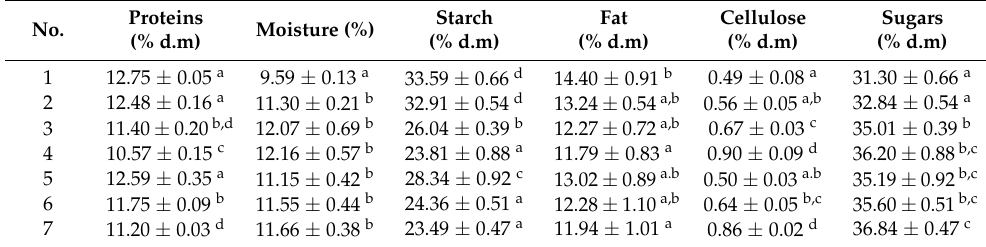
Table 2. Chemical composition of muffins with Lyo apple and OT+Lyo apple powder. No.